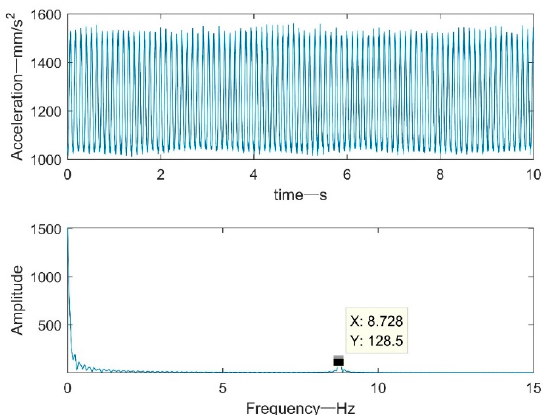
Figure 11. Vibration table vibration acceleration and frequency domain spectrum.